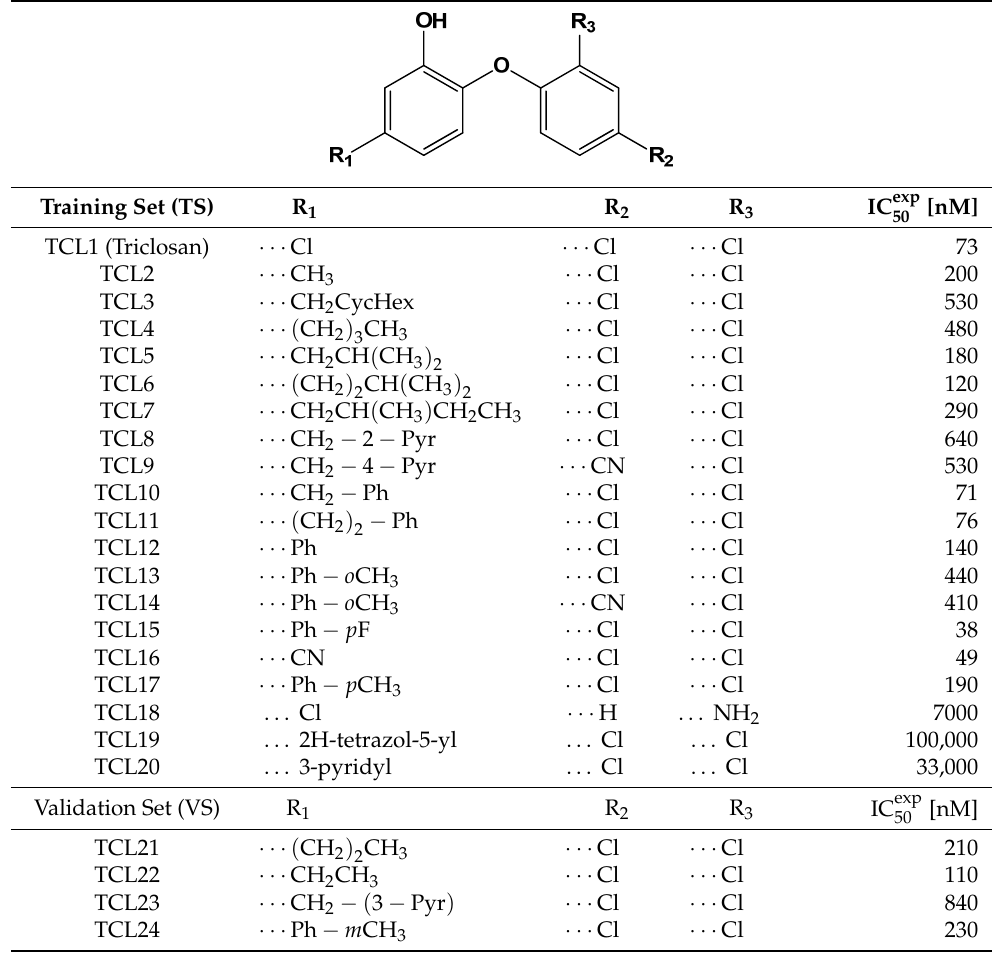
Table 1. Training and validation sets of TCL inhibitors used for the preparation of QSAR models of Pf ENR inhibition. The experimental activities were taken from [21,23,25,27].